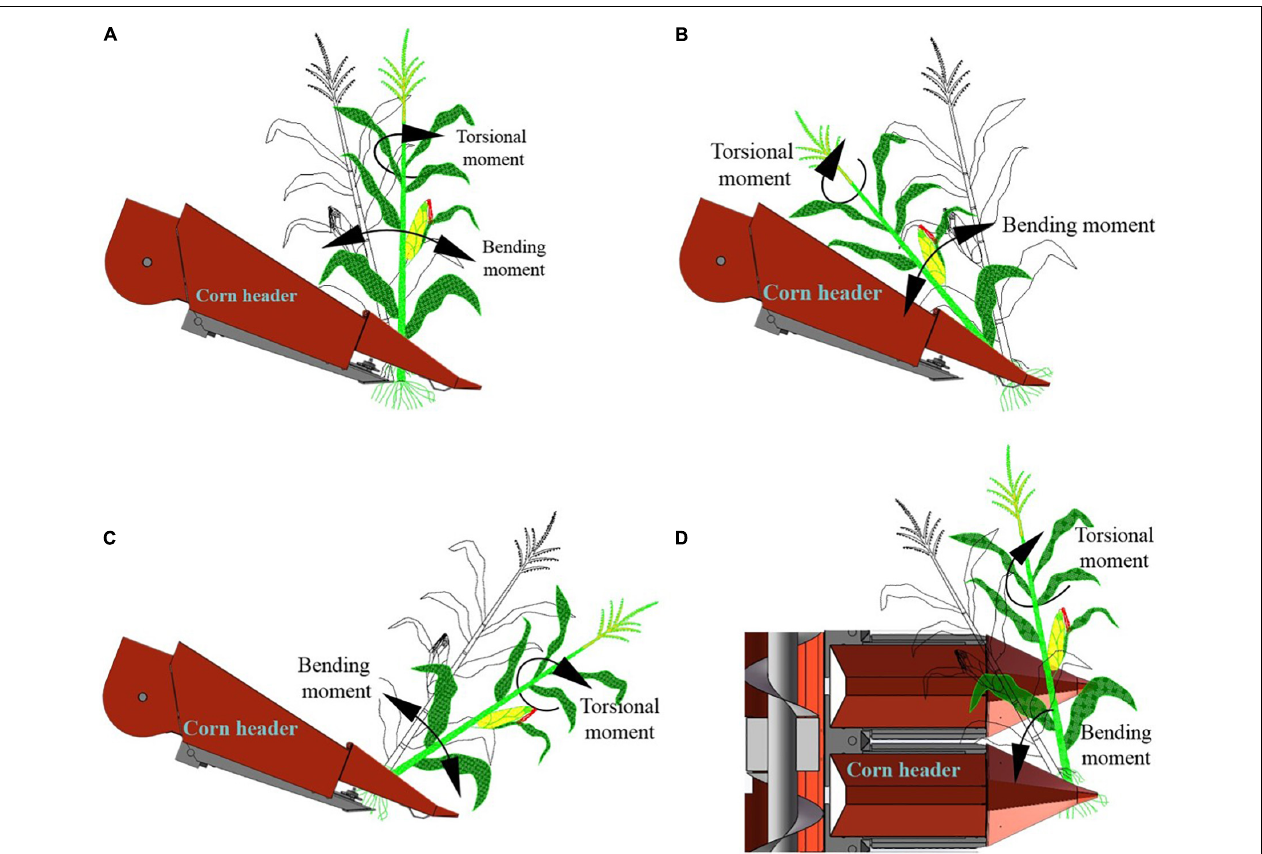
FIGURE 6 | Measurement methods of forces on upright and lodged corn stalks. (A) Upright stalks; (B) forward lodged stalks; (C) reverse lodged stalks; (D) lateral lodged stalks.